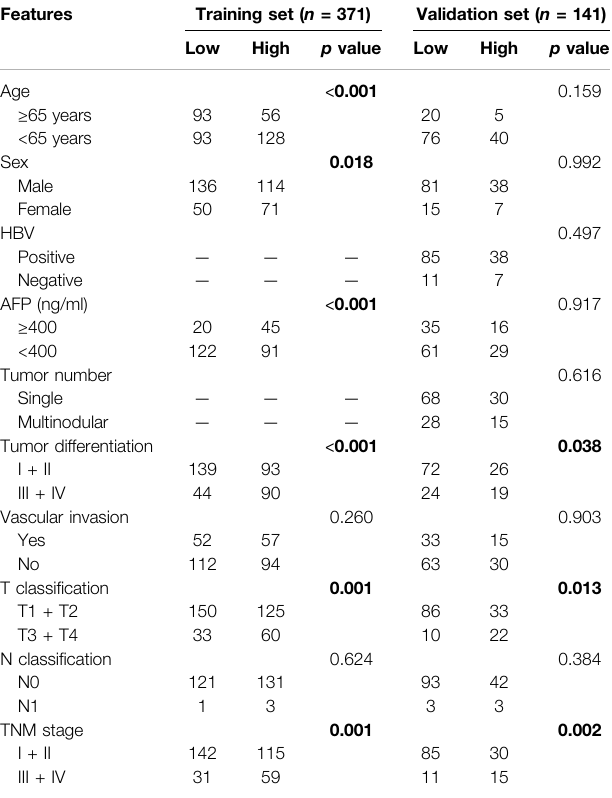
TABLE 2 | The relationships between ASF1B expression and patients ’ clinical features in TCGA database and our Center. Features Training set ( n =